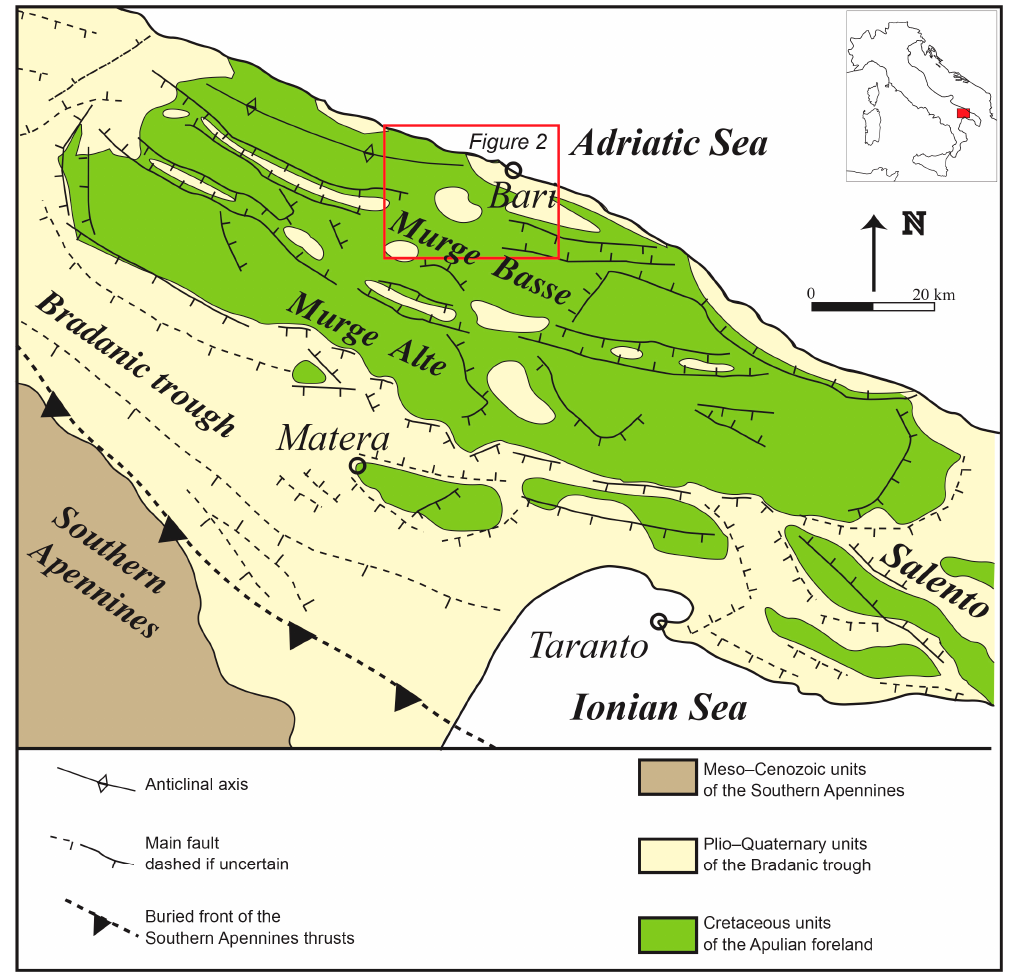
Figure 1. Simplified geological setting of the Murge area (modified after References [30,33]).